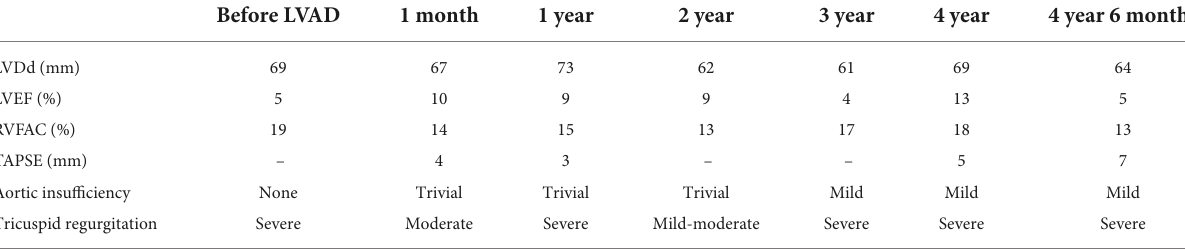
TABLE 8 Trend of echocardiographic data in Case